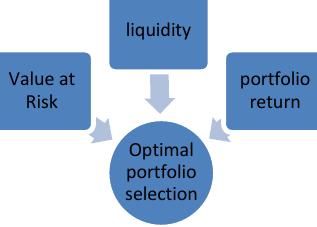
Figure 3. Selected Expert Variables (Research